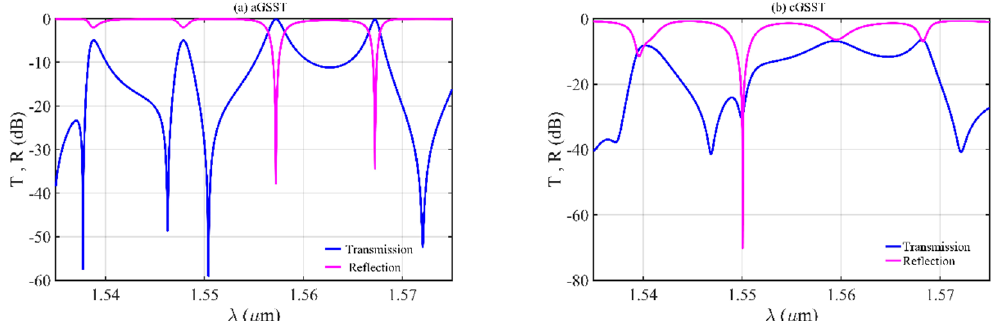
Figure 6. Transmission and reflection spectra of Sagnac ring coupled 1 × 3 MOMRs based on ( a ) aGSST and ( b ) cGSST. ( a ) aGSST and ( b ) cGSST.